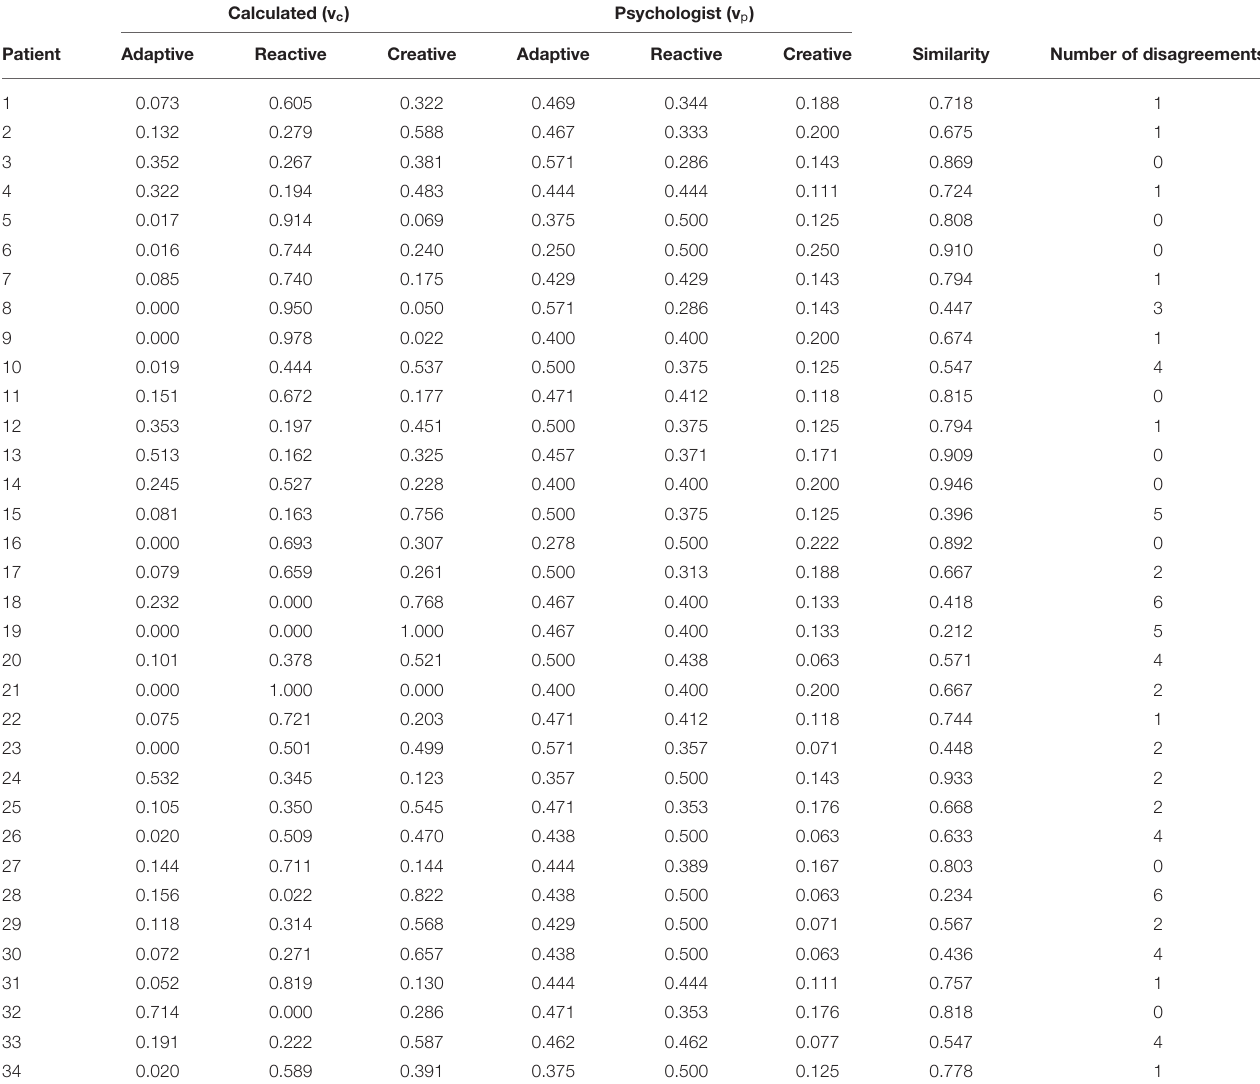
TABLE 5 | Cosine similarity between the mental functioning pattern calculated by the proposed method and that from the evaluation by a psychologist. Calculated (v c